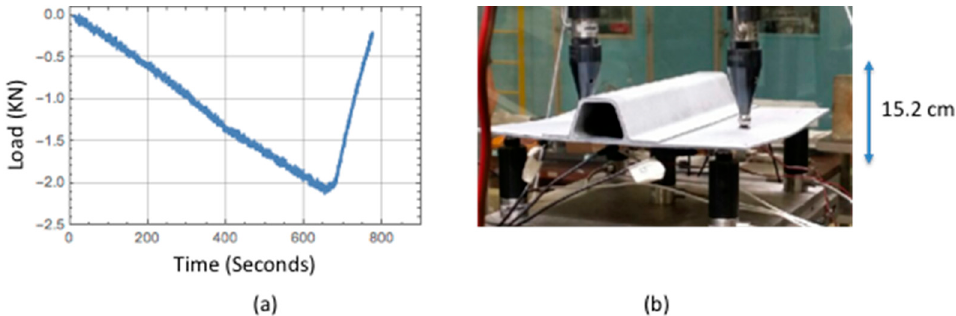
Figure 2. Single stringer hat-stiffened composite panel applied quasi-static load: ( a ) example applied load as a function of time; ( b ) panel deformation due to seven-point bend test.